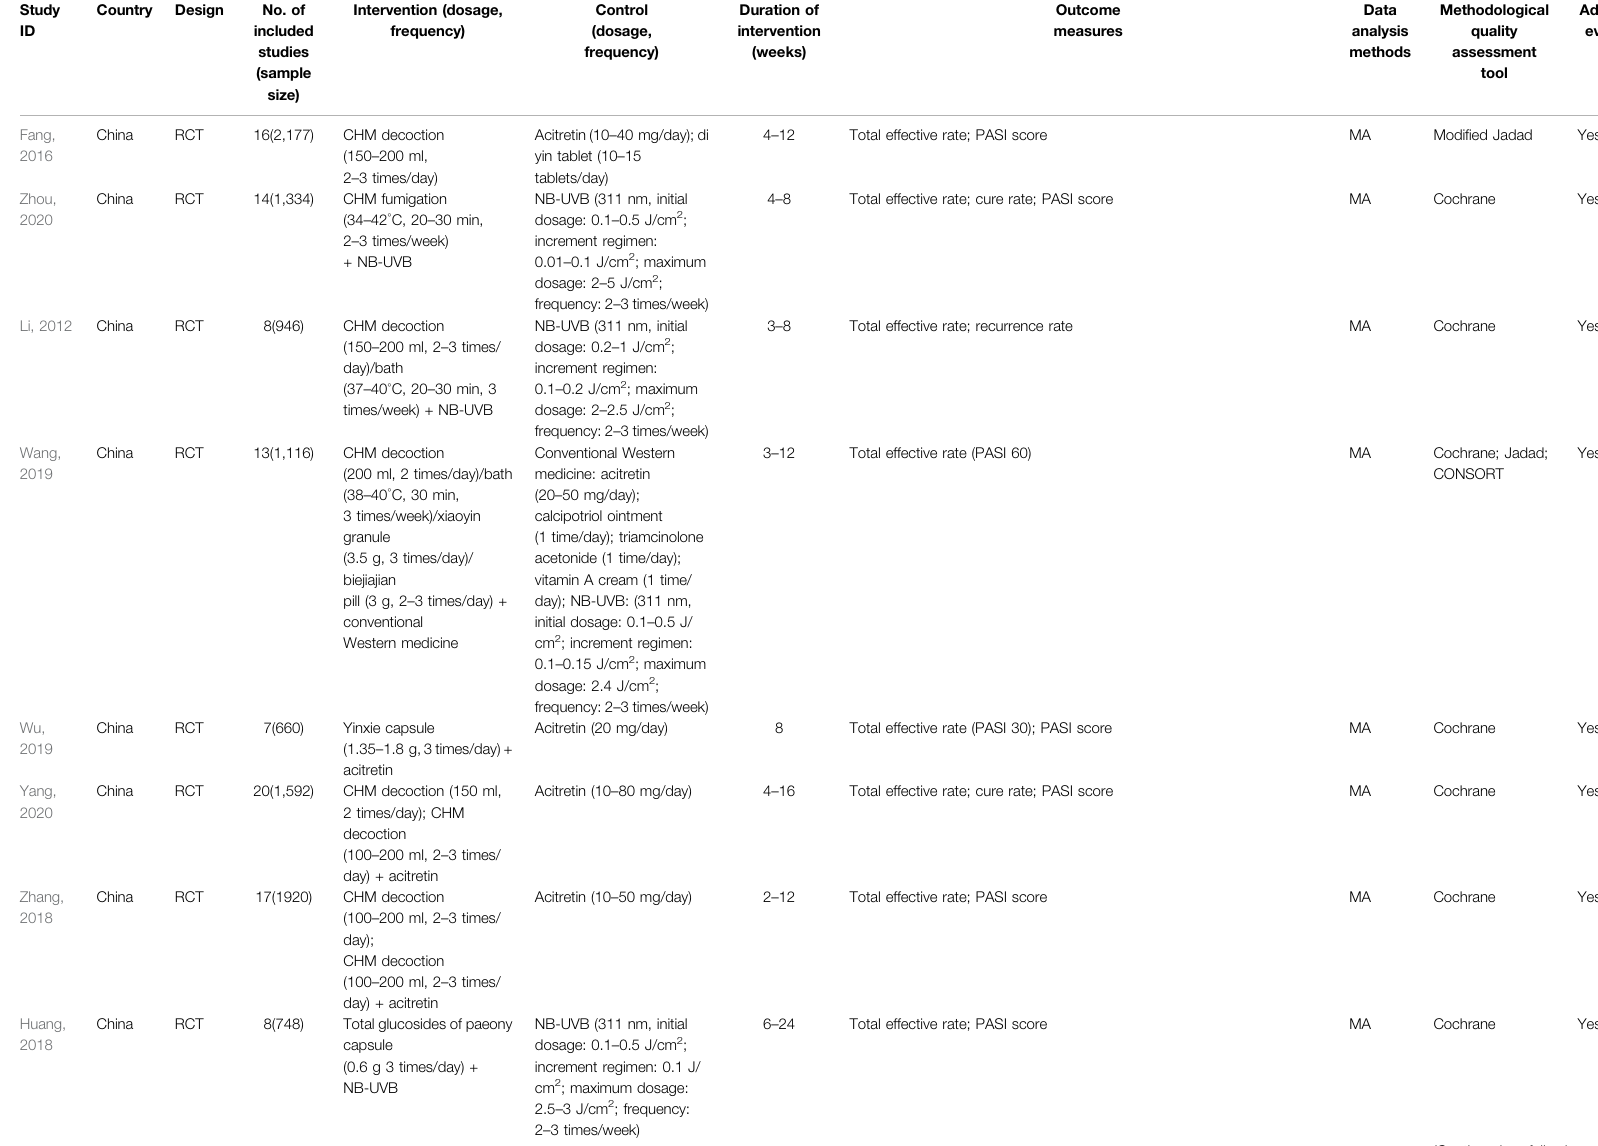
TABLE 1 | Characteristics of the included